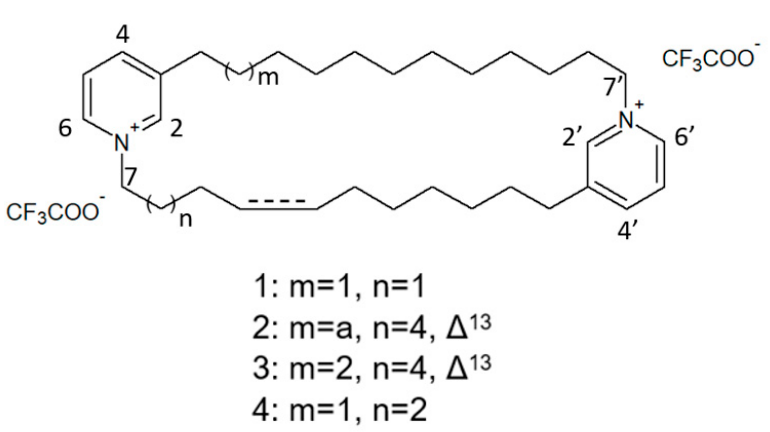
Figure 17. Structures of cyclostellettamine G (1), dehydrocyclostellettamine D (2), dehydrocyclostellettamine E, (3) and cyclostellettamine A (4) [78].